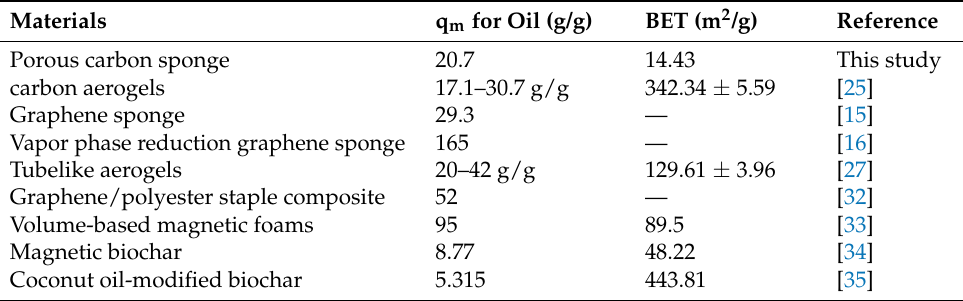
Table 1. Comparison of performance between PCS and similar